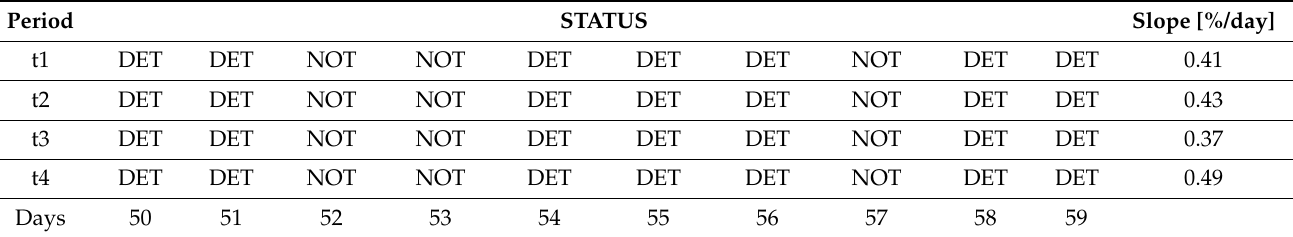
Table 3. The detailed clear-sky condition statuses for averaging intervals t 1 – t 4